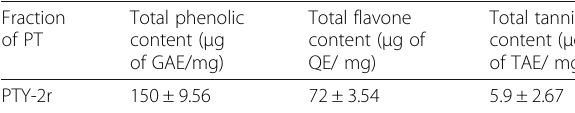
Table 1 Quantitative estimation of phytochemicals present in PTY-2r